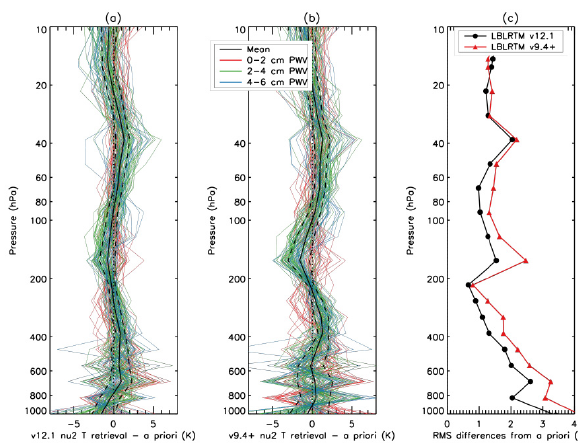
Fig. 8. Mean (solid line) and standard deviation (error bars) of the differences between the 120 temperature profiles retrieved with LBLRTM v12.1 and v9.4 + . Dashed lines show the mean differ- ences for the spectra with 0–2cm (green), 2–4cm (blue), and 4– 6cm (orange) PWV. Note that these temperature retrievals used the CO 2 ν 2 band but not the CO 2 ν 3